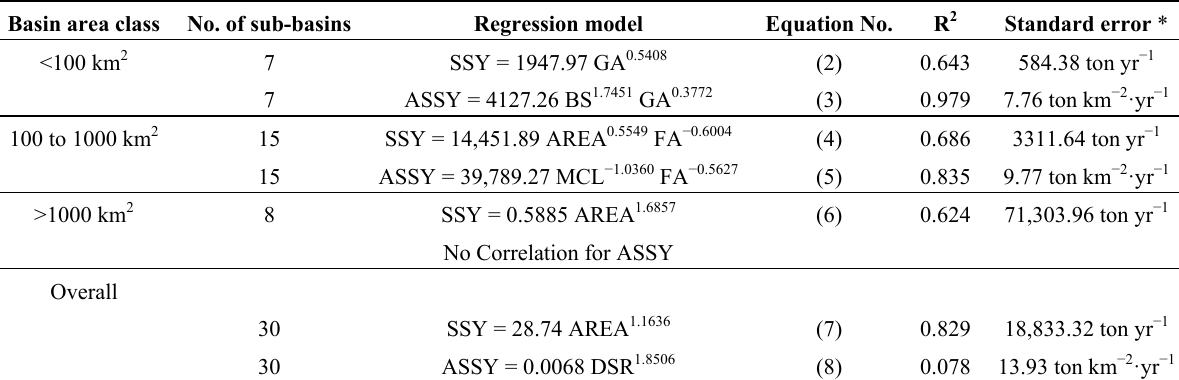
Table 7. Results of the multiple regression